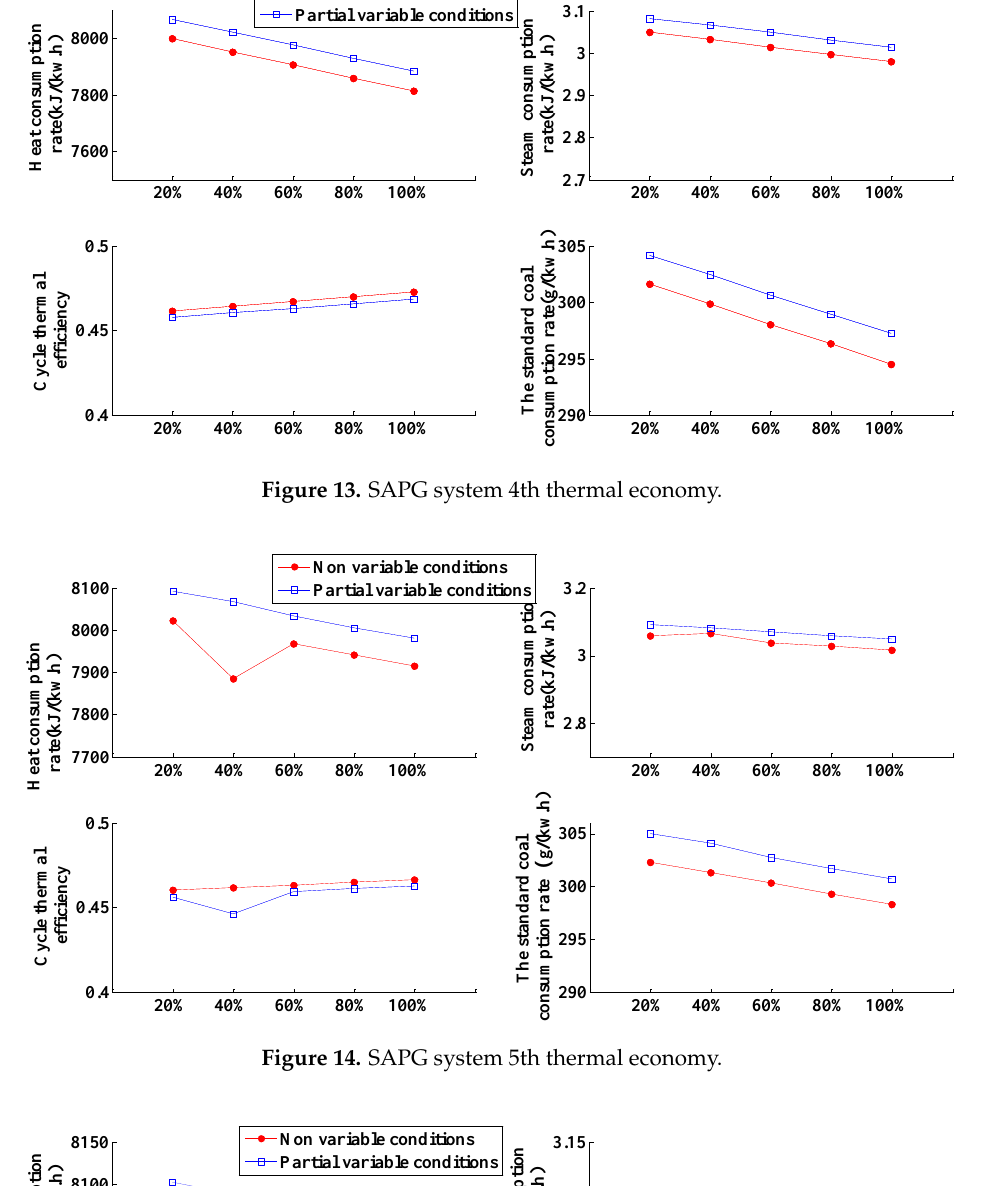
Figure 12. SAPG system 3rd thermal economy.